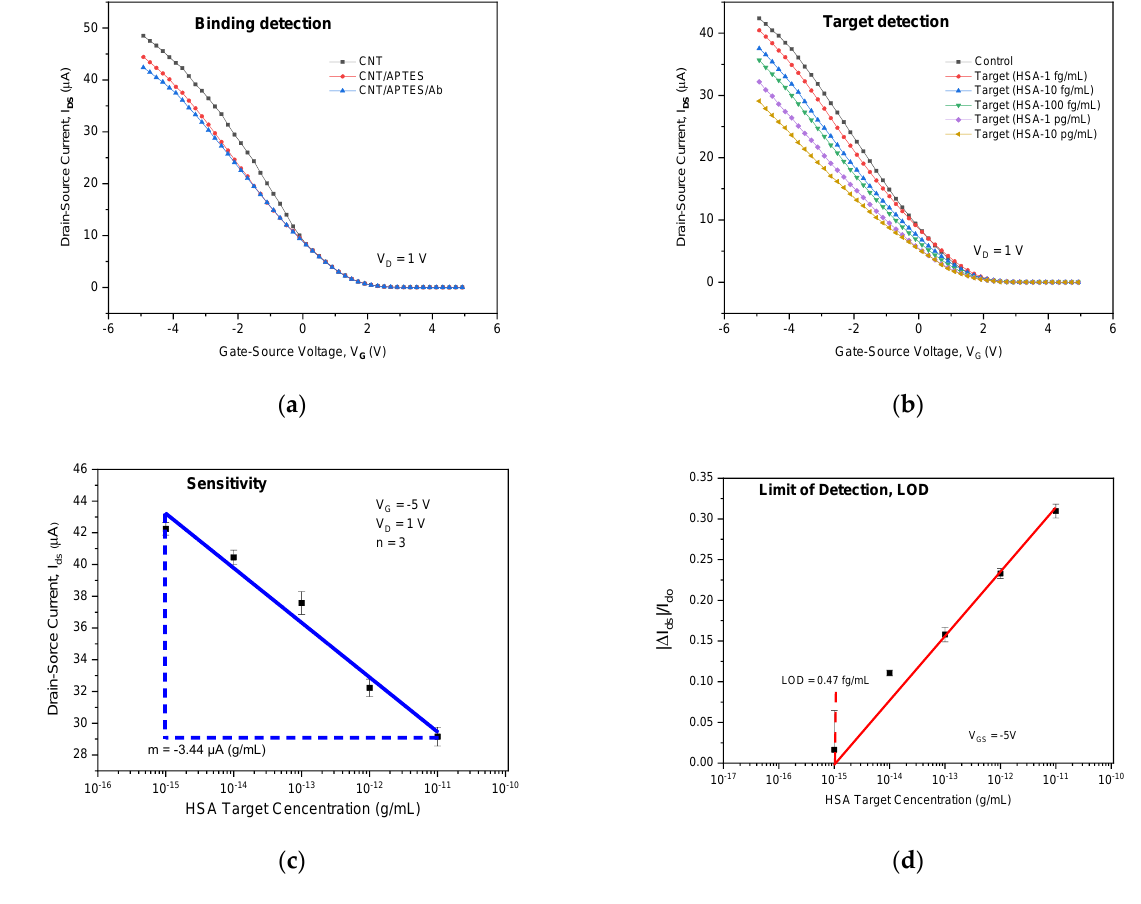
Figure 10. Electrical detection characteristics of the random SWCNT-FET (CoMoCAT type) biosensor for HSA: ( a ) transfer curve of the SWCNT-FET for binding detection with APTES and Ab; ( b ) transfer curve of the SWCNT-FET in response to the HSA target (1 fg/mL to 10 pg/mL); ( c ) I D response curve of the biosensor at different HSA target concentrations whereby the blue line shows the curve fitting for a linear drain current in the varying HSA target concentration at 3.44 µ A.(g/mL) − 1 (380/decade of change in the HSA target); ( d ) the calibration curve of the relative change in I D determines the LOD where I do = 4.26 × 10 − 5 µ A, in which I do is the base current in the applied antibody before varying HSA concentrations were introduced.